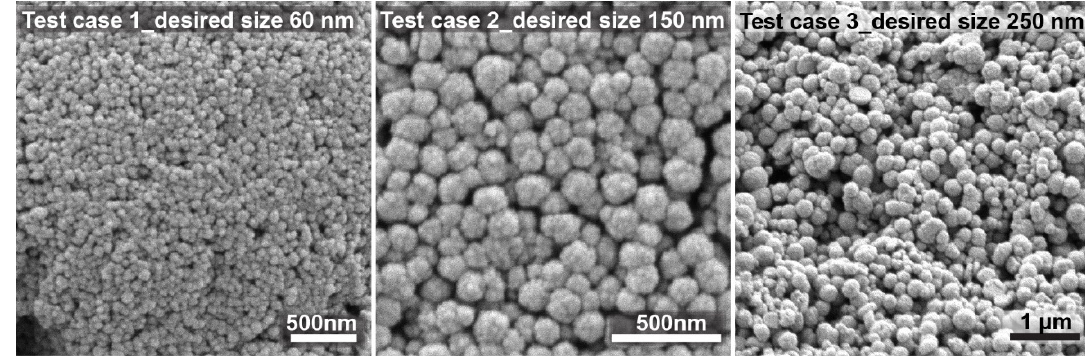
Figure 7. Test runs to prove that the model is working after optimization.